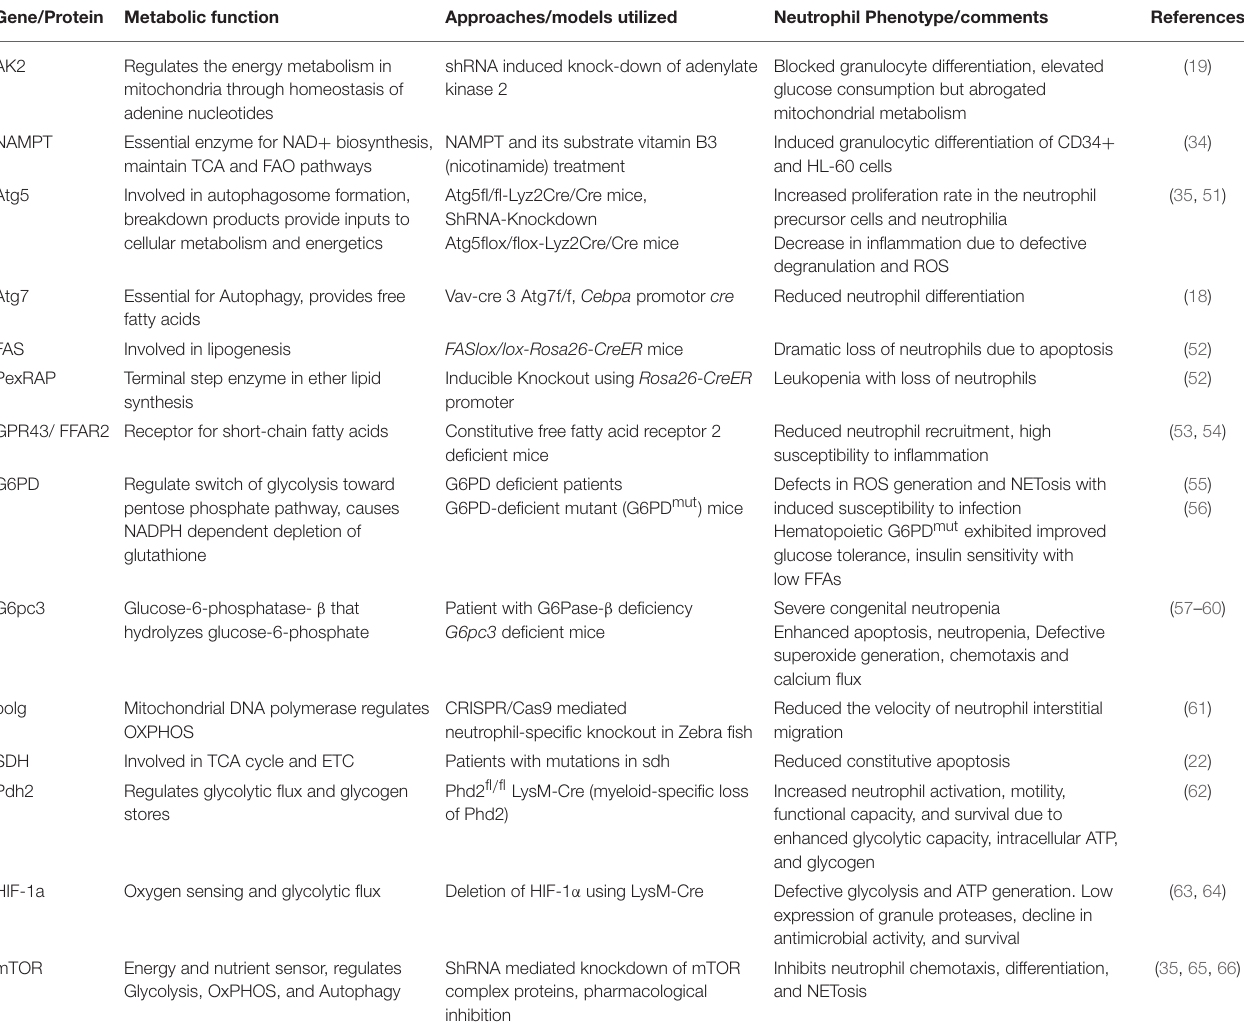
TABLE 2 | Summary of distinct genes/proteins involved in metabolism and regulating neutrophil functions. Gene/Protein Metabolic function Approaches/models